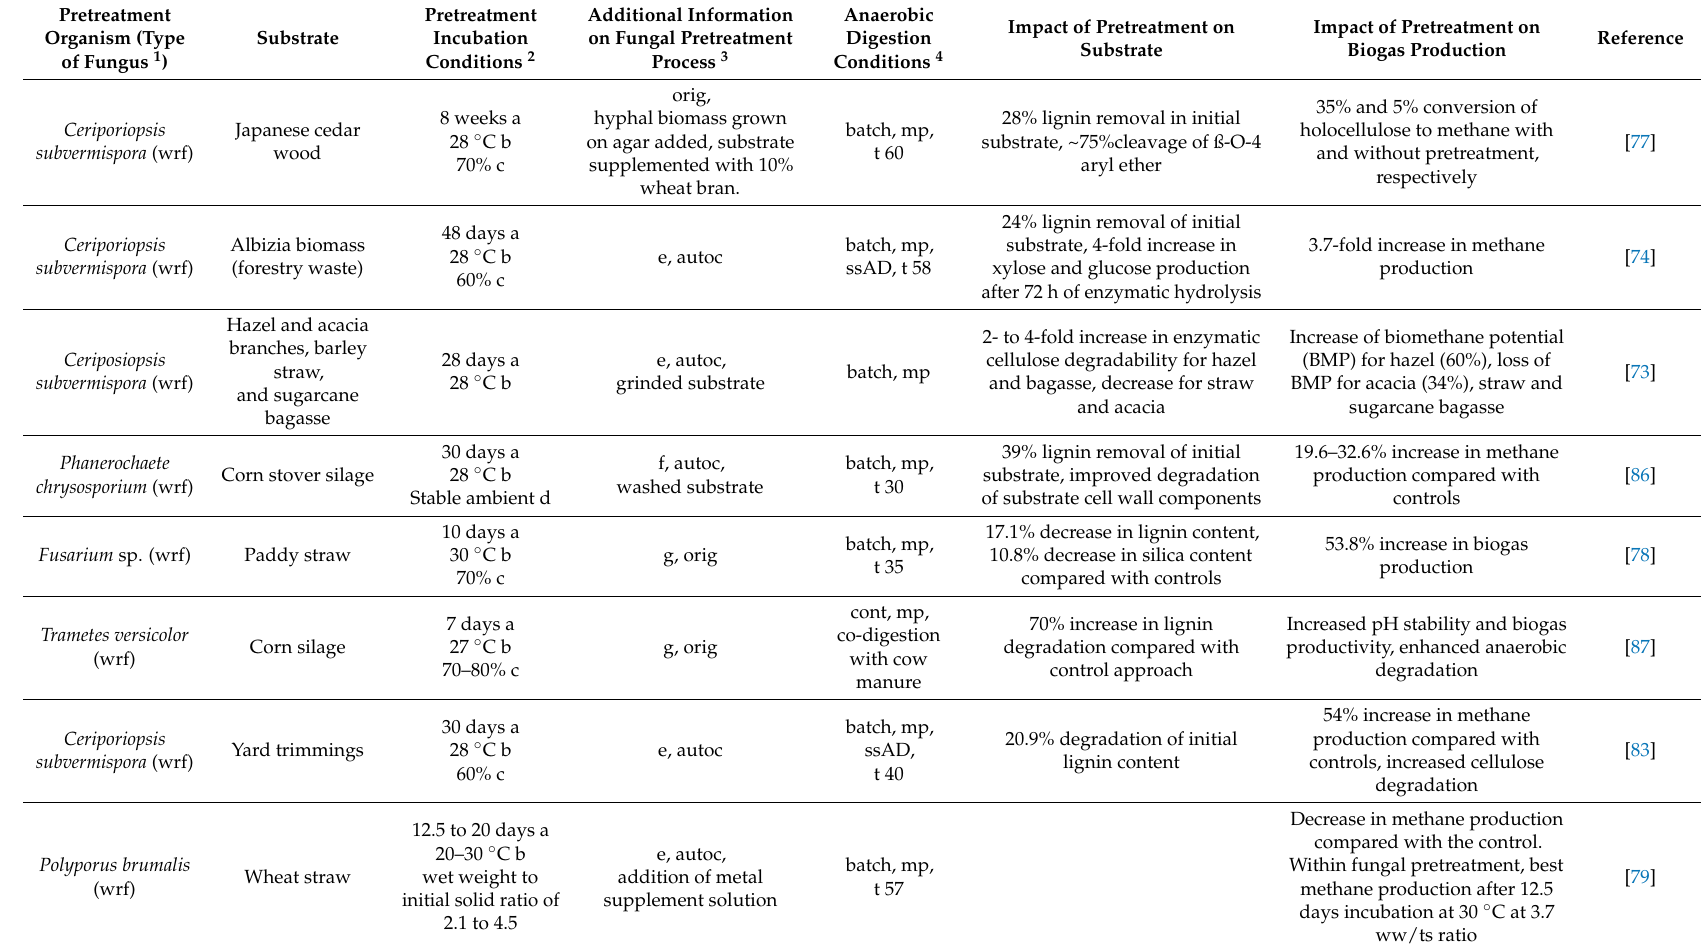
Table 1. Comparison of different fungal pretreatment strategies for enhanced biogas